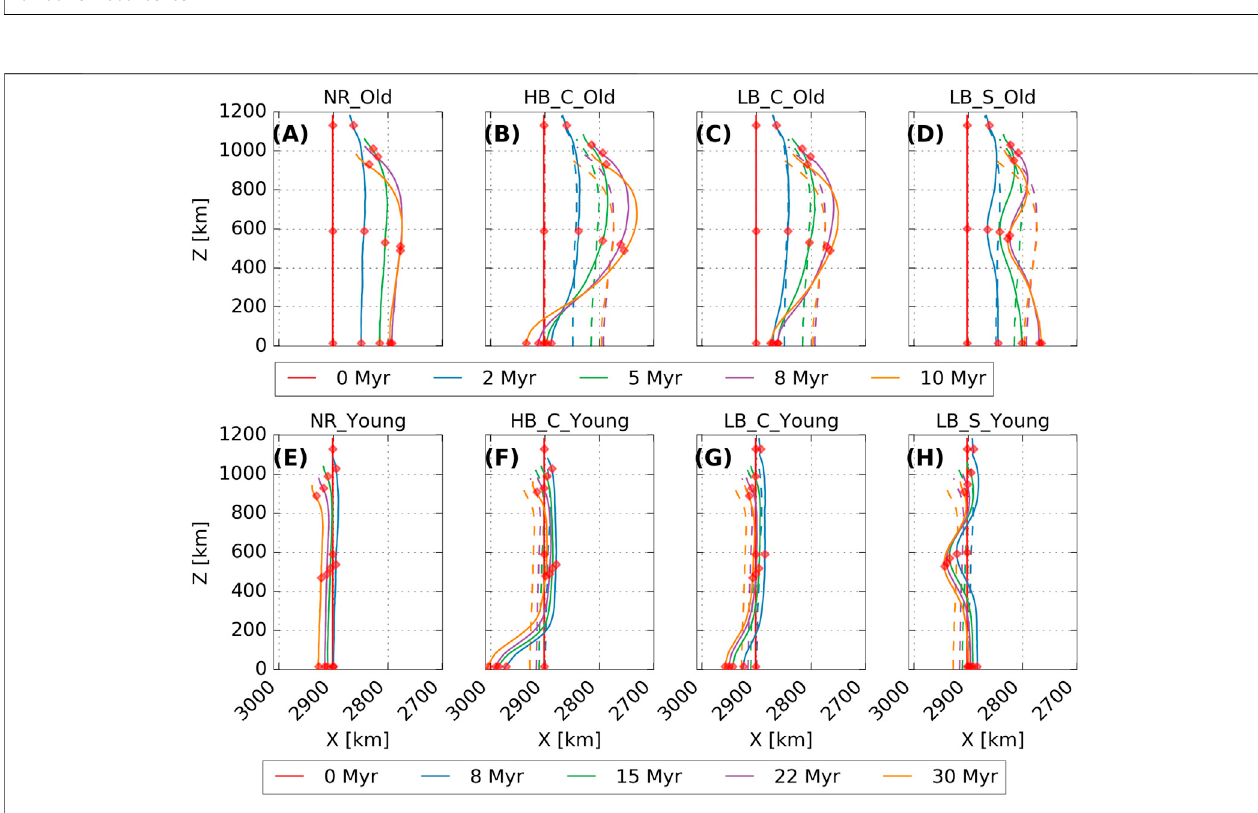
FIGURE3| Temporalevolutionoftrenchshape,correspondingtothefrontoftheplatemeasuredat20kmdepth,forOld (A – D) andYoung (E – H) models.Dashed lines in panels (B – D) and (F – H) represent the location of the trench in the corresponding reference models without a ridge (cases NR_Old and NR_Young). Red diamondsmarkthelocationwheremotionofthetrench andslabweremeasured,withresults displayed in Figures4 , 5 .Notethatthe X and Z axes aredifferentlyscaled.